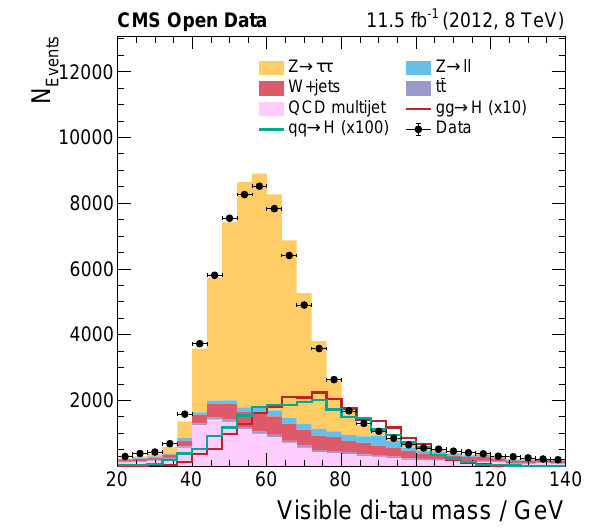
Figure 2. Analysis of Higgs boson decays to two tau leptons using data and simulation of events at the CMS detector from 2012